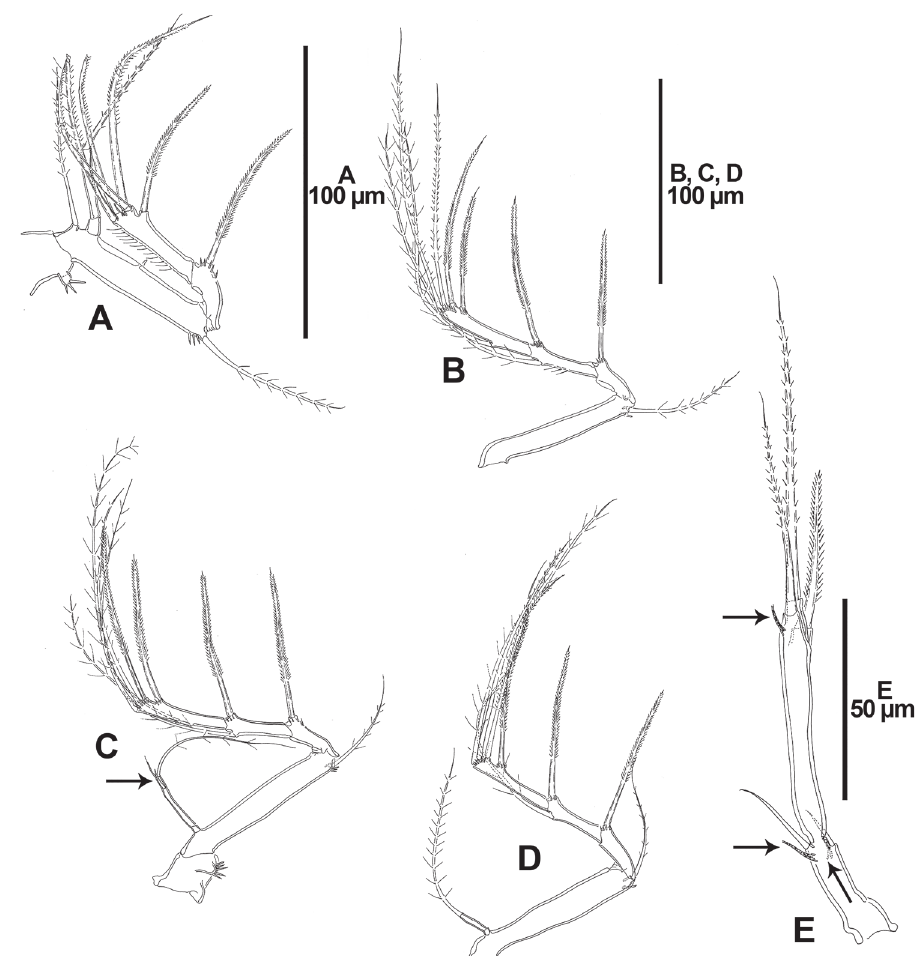
Figure 10. Dendropsyllus californiensis sp. n., female holotype. A P1, anterior B P2, anterior C P3, ante- rior, outer spine-like element of second endopodal segment indicated with an arrow D P4, anterior e P5, lateral, arrows showing tube